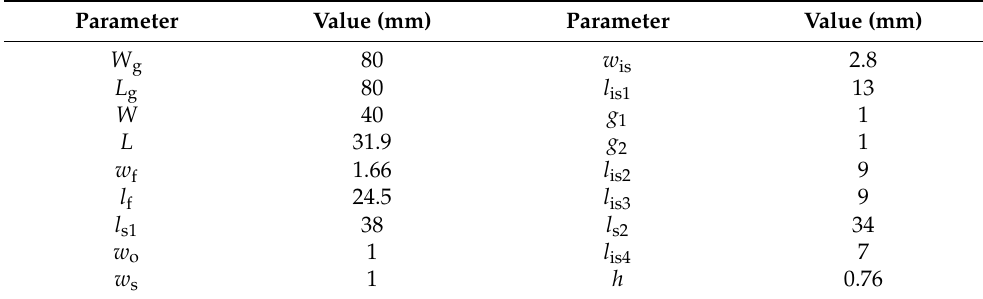
Table 1. Design parameters of the rectangular MPA loaded with four different types of slots.